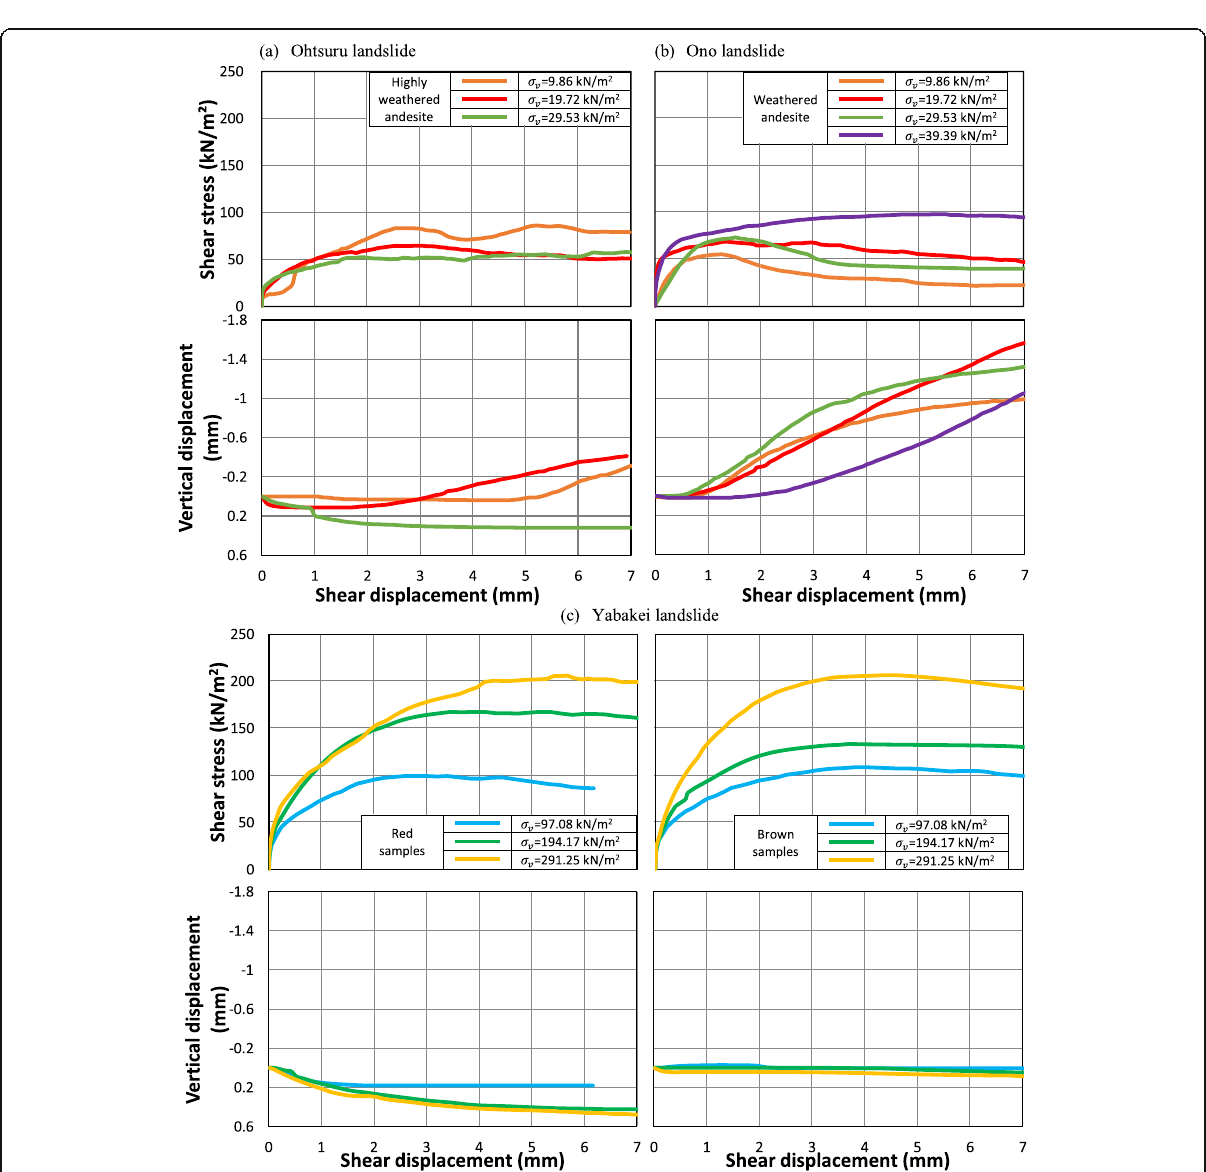
Fig. 13 Shear stress-shear displacement and vertical displacement-shear displacement behaviour in soil materials in ( a ) Ohtsuru landslide, ( b ) Ono landslide, ( c ) Yabakei landslide